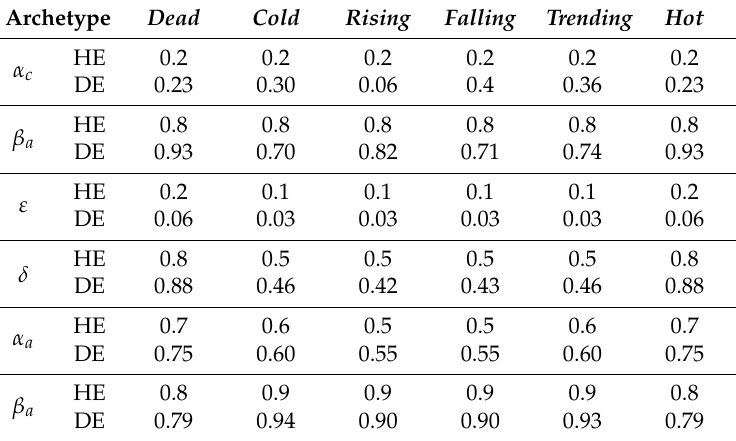
Table A1. The human expert tuning (HE) and the DE adaptation for each first layer SRF. Archetype Dead Cold Rising Falling